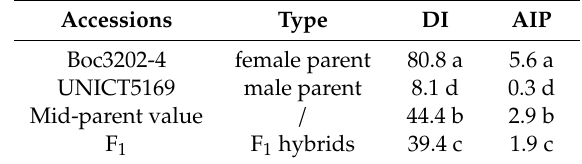
Table 3. Investigation of Xcc 4 Resistance of Parents and F 1 Hybrids.